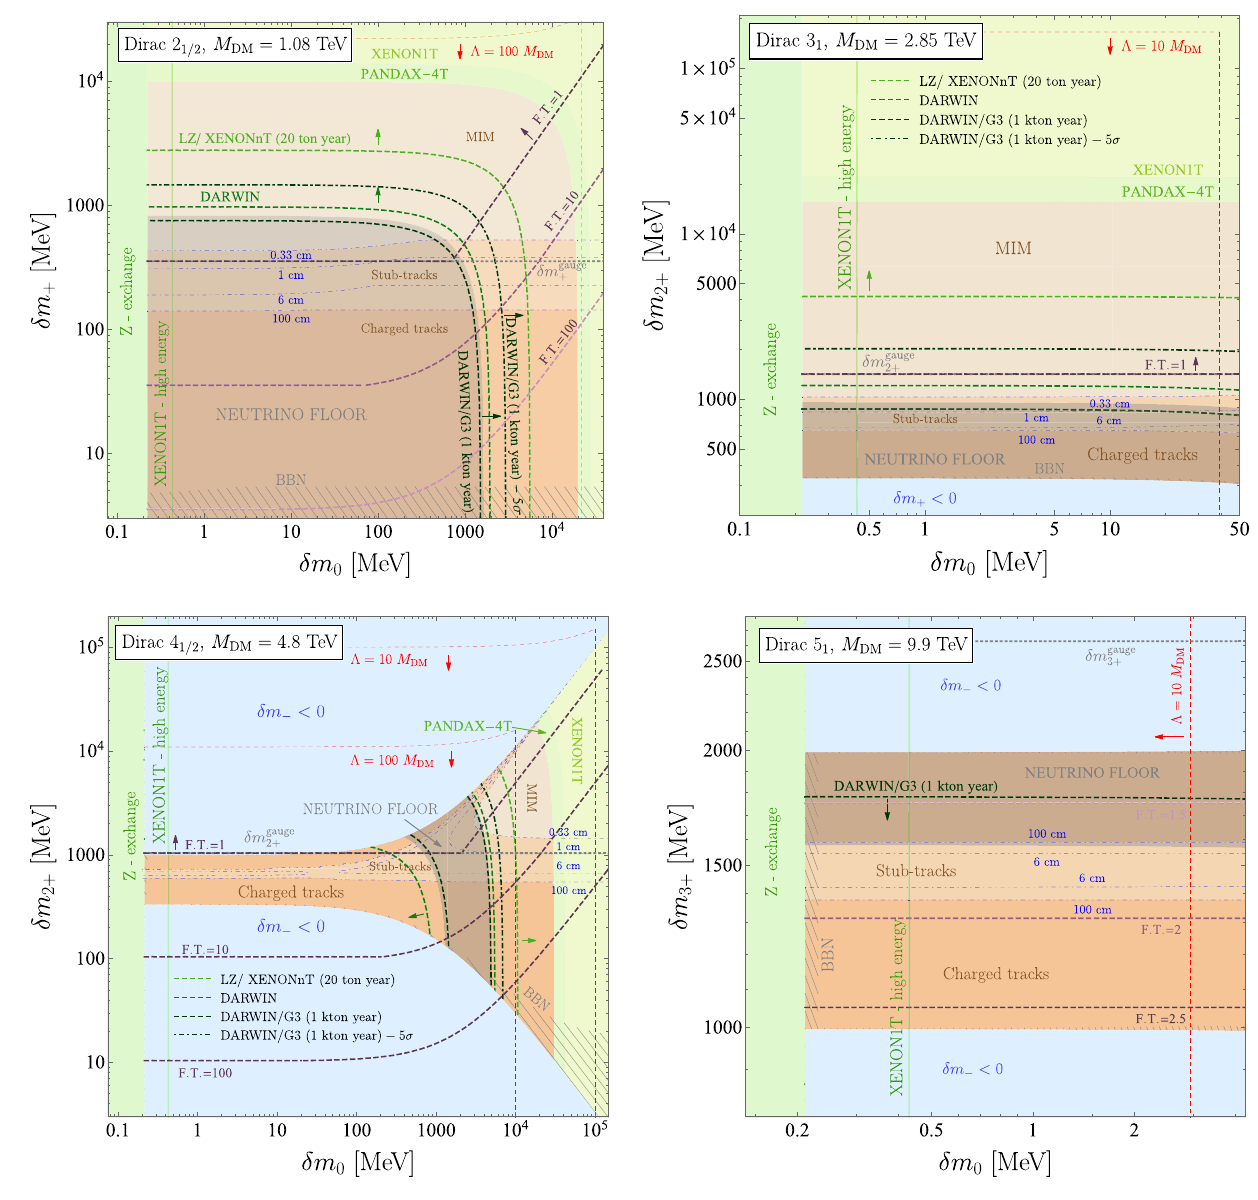
vertical XENON1T-high energy line show the ultimate reach of xenon experiments on inelastic DM (see Fig. 1). Blue dot-dashed lines cor- respond to different expected lengths of charged tracks. Accordingly, different hues of brown distinguish regions where different signatures at future colliders are expected, as defined in Sect. 4.2. In every panel the DM thermal mass gives an idea of the center-of-mass energy of an hypothetical collider which would be needed to produce a DM pair. The precise center-of-mass energy for exclusion/discovery requires a more detailed study (see Sect. 3.2 and App. D) The dashed gray line shows the EW value of δ m Q . Purple dashed lines show the contours of the M fine-tuning among the different mass splittings as defined in Eq. (12). Mass splittings above the F.T.=1 line are not fine